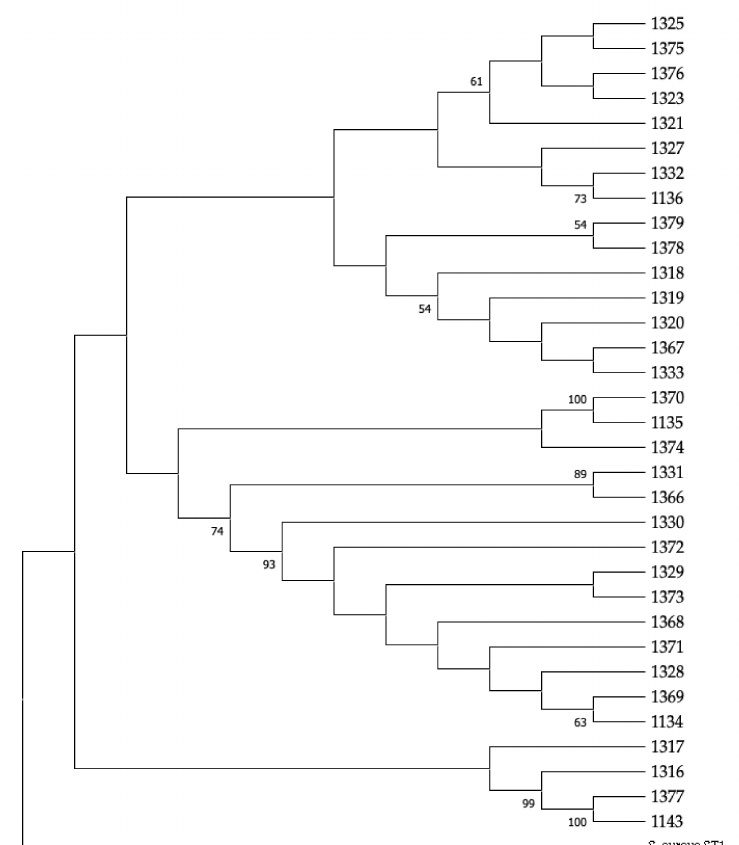
Figure 7. A maximum likelihood phylogenetic tree of 33 S. epidermidis isolates from cases of ovine mastitis in Greece in the MLST database and S. aureus ST1 as an outgroup. Bootstrap values of >50 are shown in the graph, and numbers to the right of the tree refer to the reference ID in the MLST database, which were used in the analysis. MLST: multi-locus sequence typing; ST: sequence type; ID: isolate identity in the database.